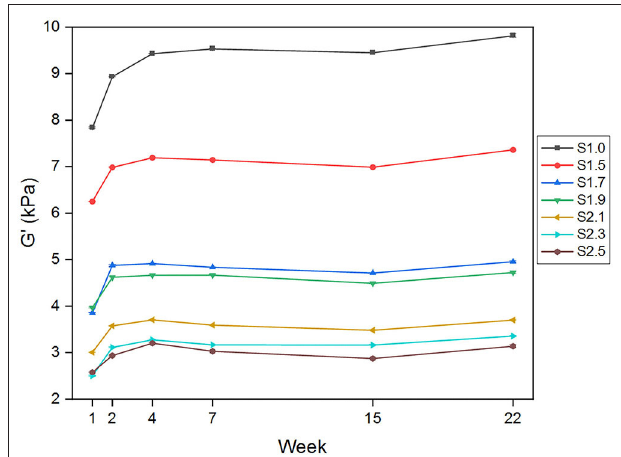
FIGURE 2 | Rheometry measurements at different timepoints (weeks post fabrication) of the complex shear modulus component G’ at 10Hz angular frequency for all the silicone samples prepared with various softener compositions.